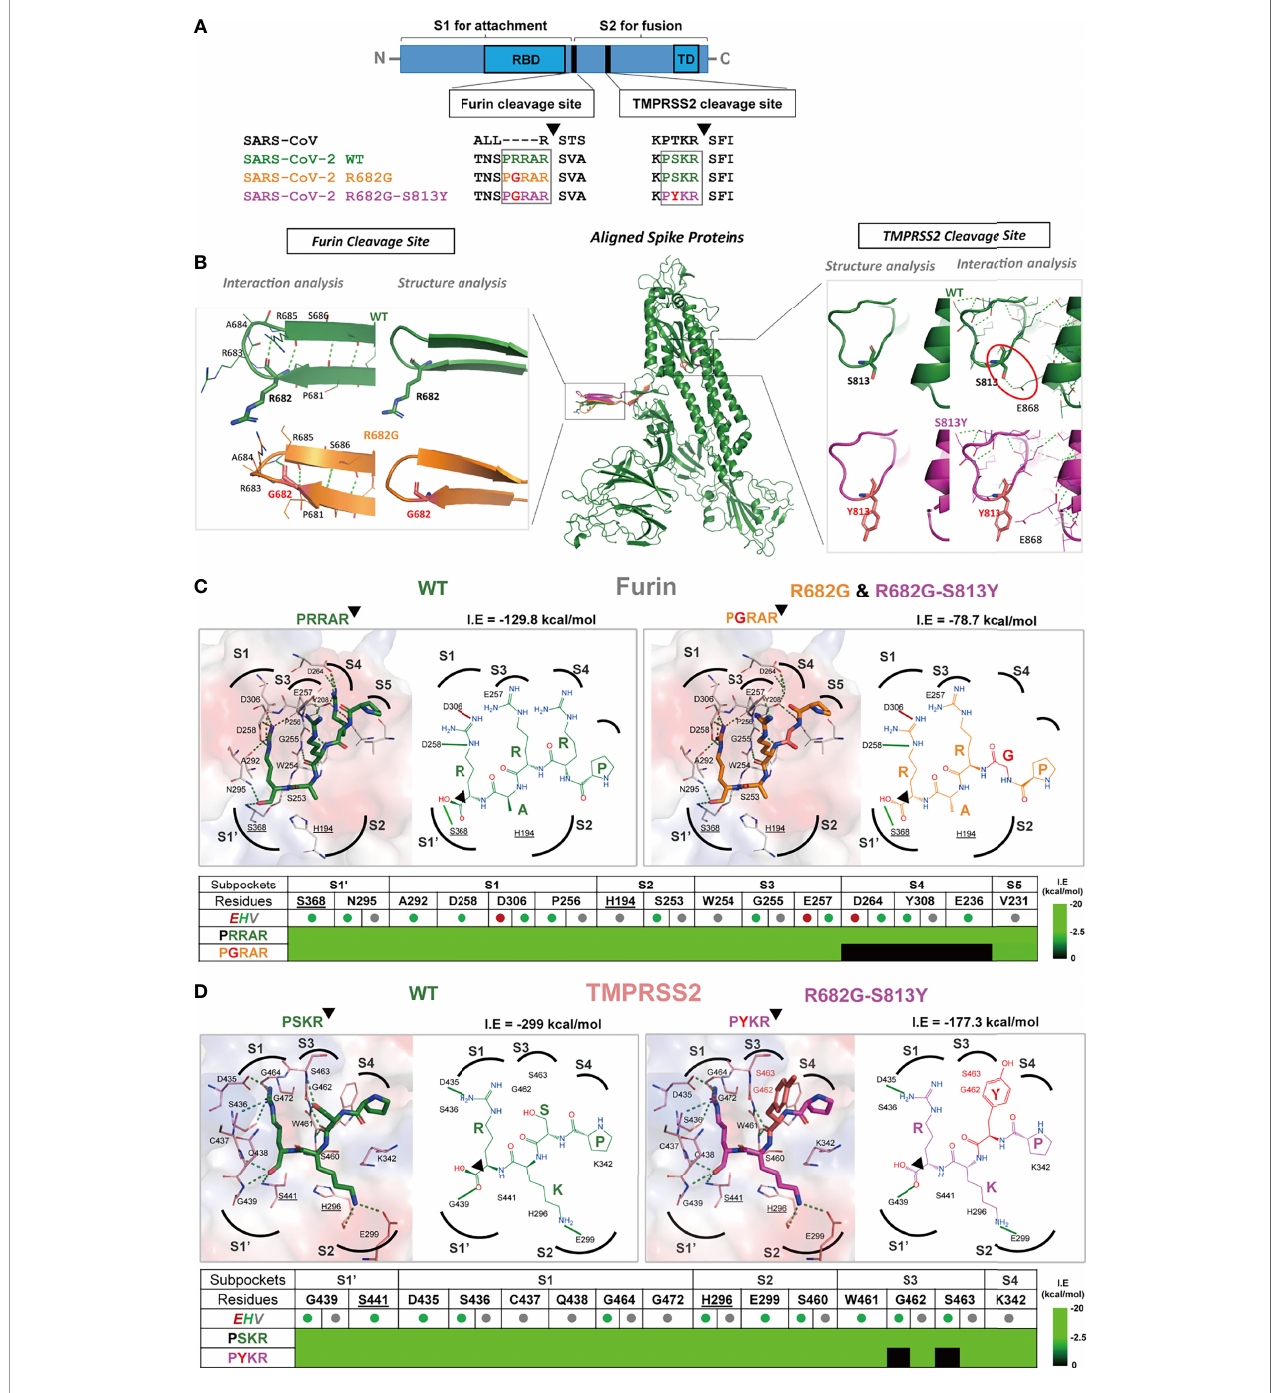
FIGURE 5 | The R682G and S813Y mutations in Spike protein lead to altered enzyme binding and proteolysis. (A) The Furin and TMPRSS2 cleavage motifs are shown in the spike protein sequences of SARS-CoV, SARS-CoV-2 WT, and mutants. Furin cleavage occurs between the S1 and S2 subunits, while the TMPRSS2 cleavage occurs within the S2 subunit. (B) The S protein structure and interactions of the WT (wild-type; green), R682G (orange), and R682G-S813Y (magenta) mutants were modeled using the Phyre2 web portal. The full spike proteins are aligned, and the speci fi c mutation sites are shown in insights of the Furin and TMPRSS2 cleavage sites. (C, D) Molecular docking of spike protein peptide substrates (of WT and mutants) with Furin and TMPRSS2 using iGEMDOCK. The protease active site (surface) and the binding poses (2D diagrams) of the WT (green stick) and mutants (mutated residue in red sticks) were shown. The active site subpockets (dotted curves) with residues (catalytic residues labels underlined) were also displayed. The interactions (solid black lines, E-dark red, H-green, V-grey) and total interaction energies (I.E in kcal/mol) were examined. The interaction table details the substrate-subpocket residue